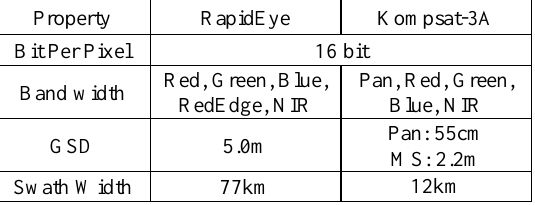
Table 1. Specification of RapidEye and Kompsat-3A images.